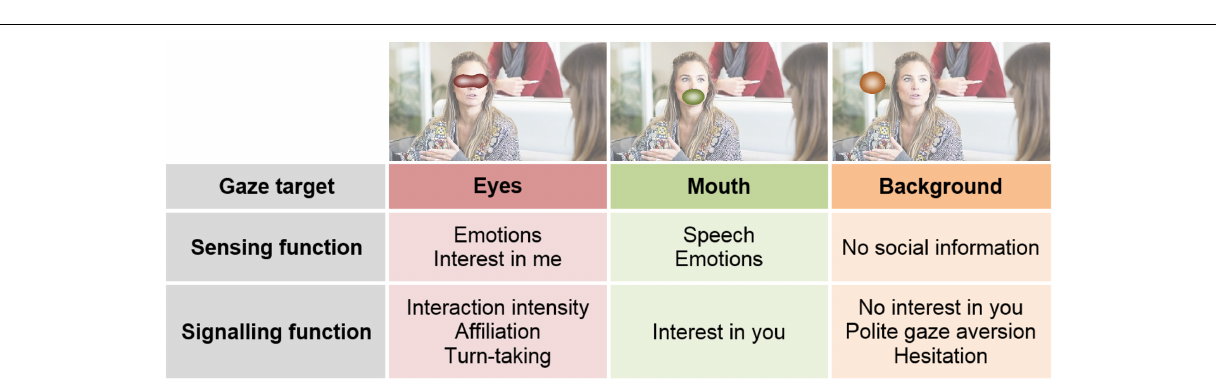
FIGURE 4 | Different sensing and signaling maps may be used in different contexts. Original image published by Max Pixel under the Creative Commons CC0 License. Original maps were obtained with Saliency Toolbox for Matlab (Walther and Koch,